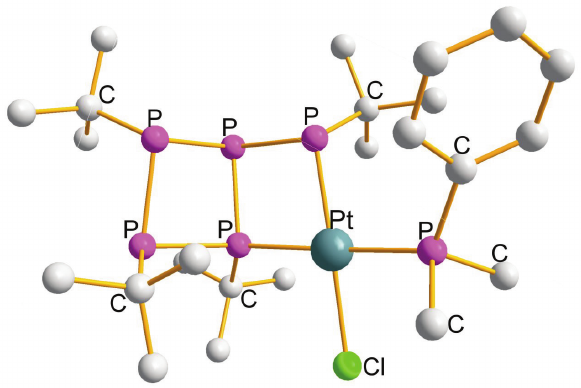
PP 2 Bu t }{P 3 (Me) 2